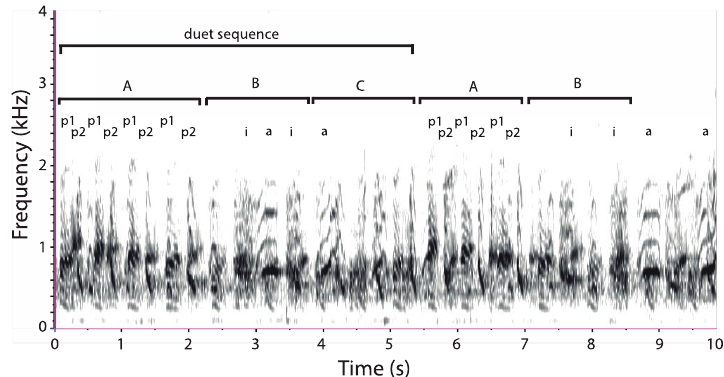
Figure 8. Joint vocalizations emitted by a pair of Cheracebus lucifer . The putative male sequence consists of three phrases (A, B, and C), which are repeated. p1 and p2 are pant syllables. i: inhaled, noisy syllables. a: putative female